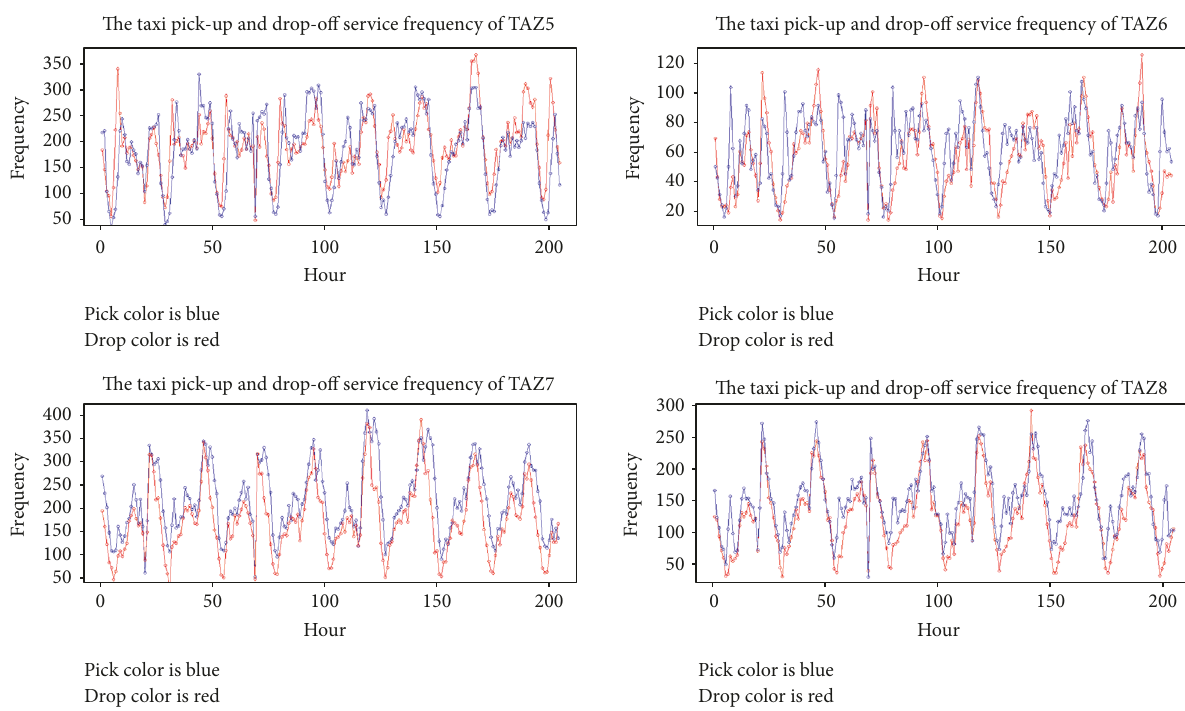
Pick color is blue Drop color is